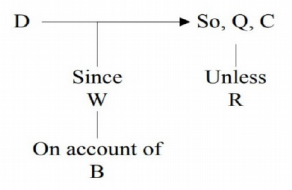
Figure 1. TAP analytical framework